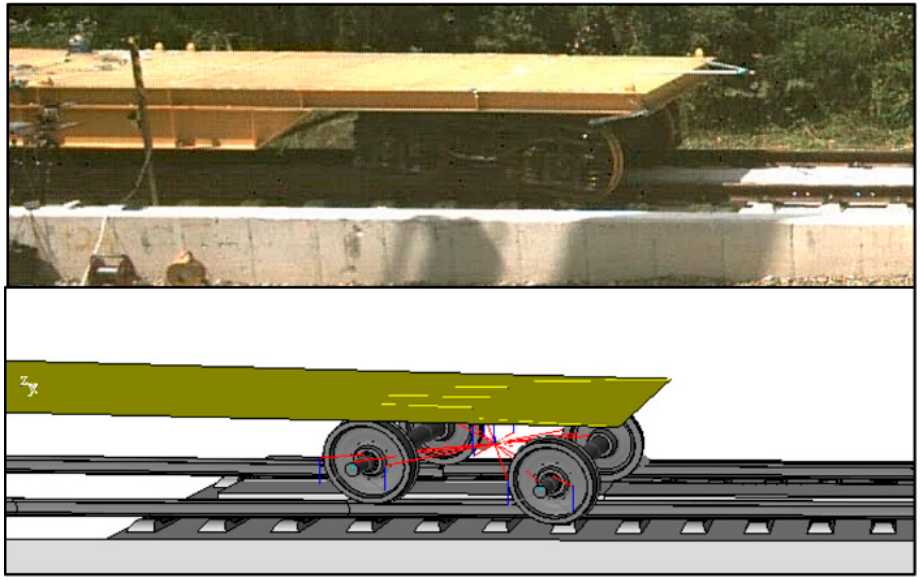
Figure 20. First collision with concrete sleeper.